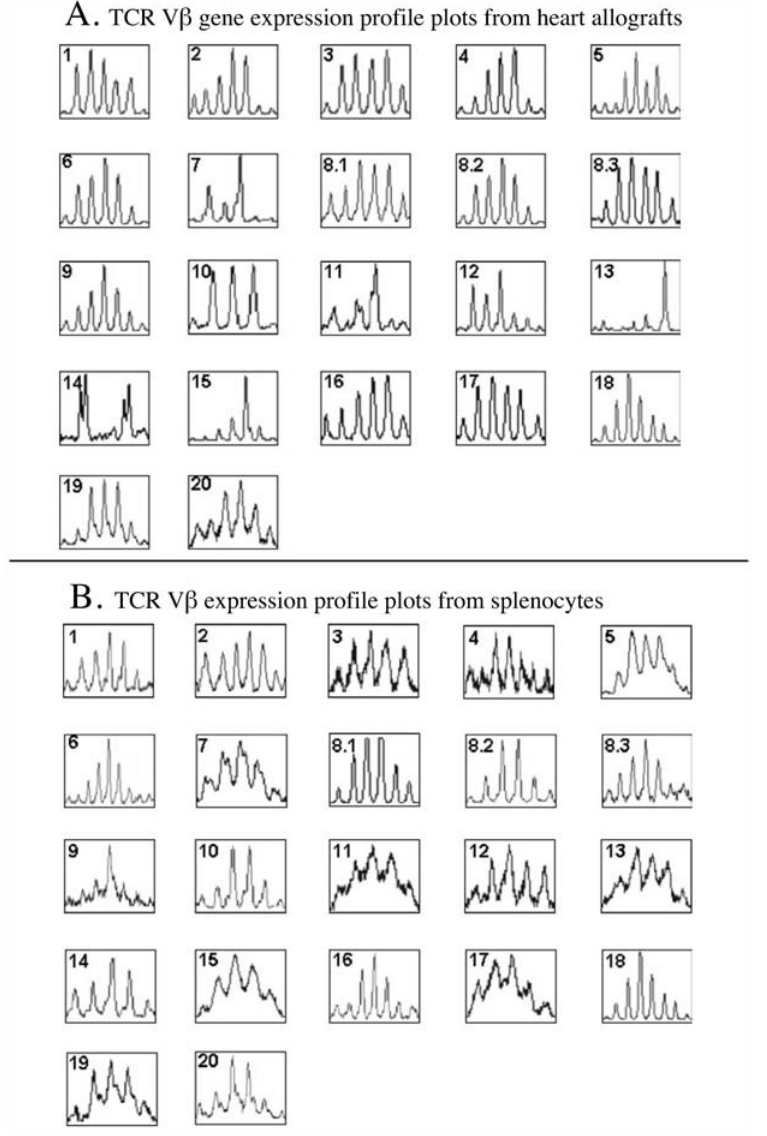
Figure 2. RT-PCR-assisted detection of expression profile of 22 known rat TCR V b genes in allochimeric protein [ a 1h u ]-RT1.A a class I molecule -induced long-term tolerant ACI recipients bearing WF heart allografts (survival day . 100). (A) TCR V b gene expression profile plots from heart allografts. (B) TCR V b gene expression profile plots from splenocytes.